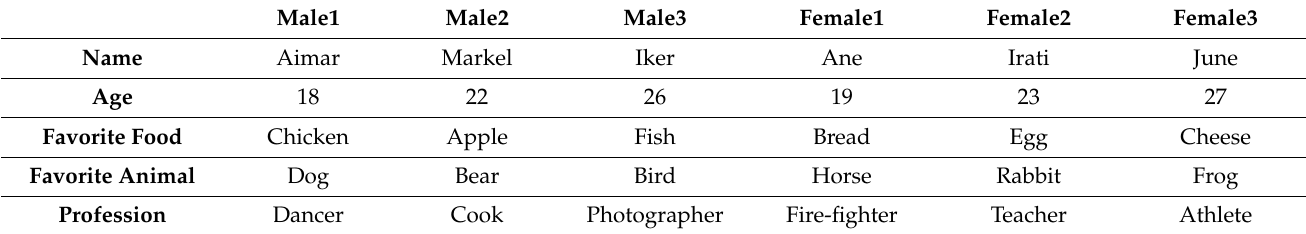
Table 1. Basic information provided by each male and female